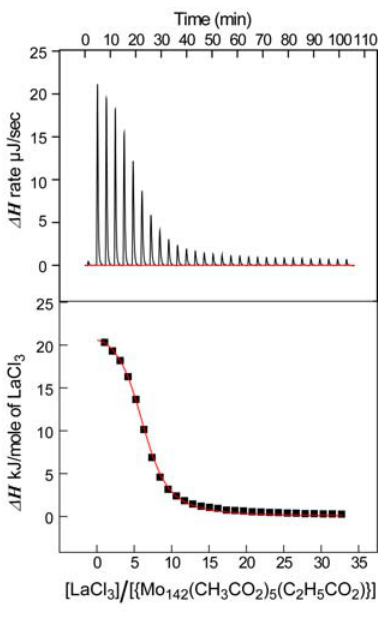
Figure 3. Binding isotherm for the titration of {Mo 293 K. An 20 μ M solution of {Mo injections of LaCl shown in upper panel. The area under each injection signal was integrated and plotted against molar ratio in lower panel. The red-colored curve represents a nonlinear least squares fit of the reaction heat for the injection with the assumption of a single binding site.